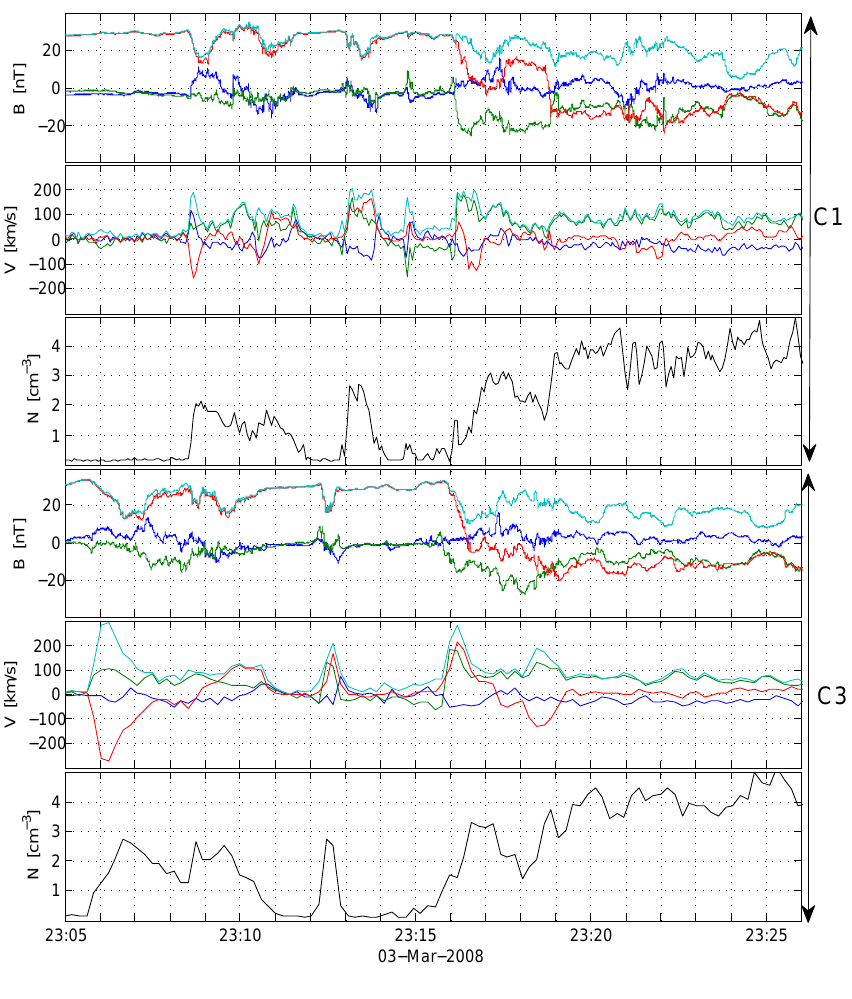
Fig. 8. Magnetic field, ion velocity and ion density during event 2, on 3 March 2008 at 23:05–23:26UT at the magnetopause slightly duskward and northward from the subsolar point. Data is shown in GSM coordinates. For B and V , light blue curve gives the absolute magnitude. Dark blue, green and red are X , Y and Z components,